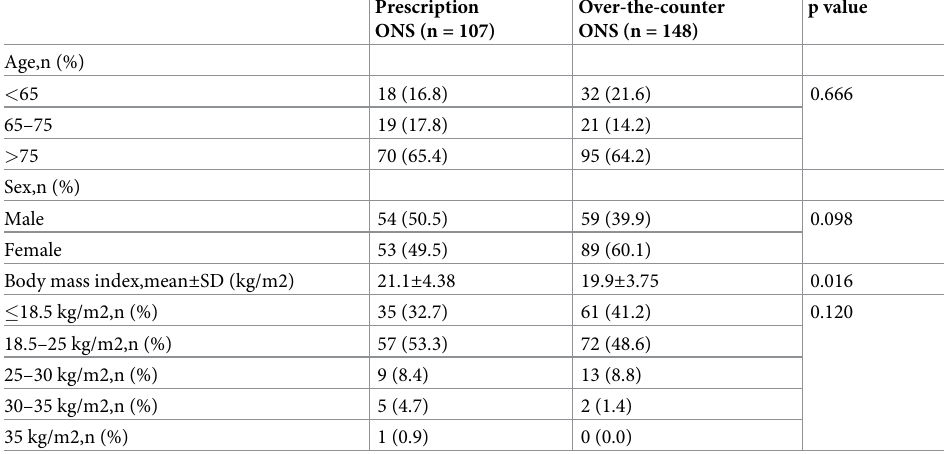
Table 3. Patients’